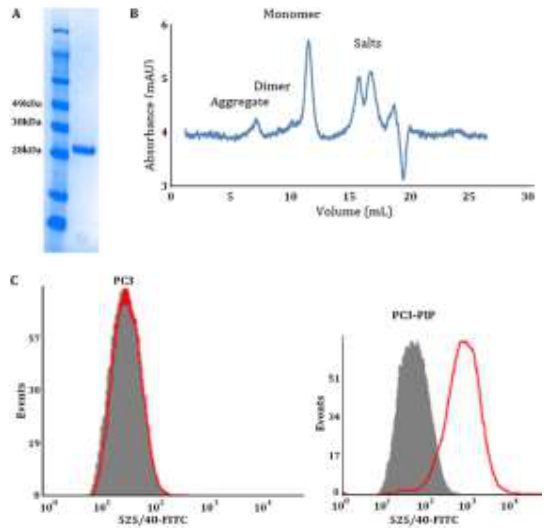
Figure. 2. Purification and affinity binding assay of J591 scFv-pAzF . A) SDS PAGE of purified J591 scFv- pAzF showing ~28 kDa in MW. B) Size exclusion chromatography shows that the scFv expressed in periplasmic space contains mainly monomeric protein with low protein aggregates and protein dimers. C) Flow cytometry analyses indicated that J591 scFv-pAzF can specifically bind into PSMA positive human prostate cancer cell line (PC3-PIP), but not into negative cell line (PC3). Histogram, grey: cells with PBS (control); red: cells with J591 scFv pAzF.